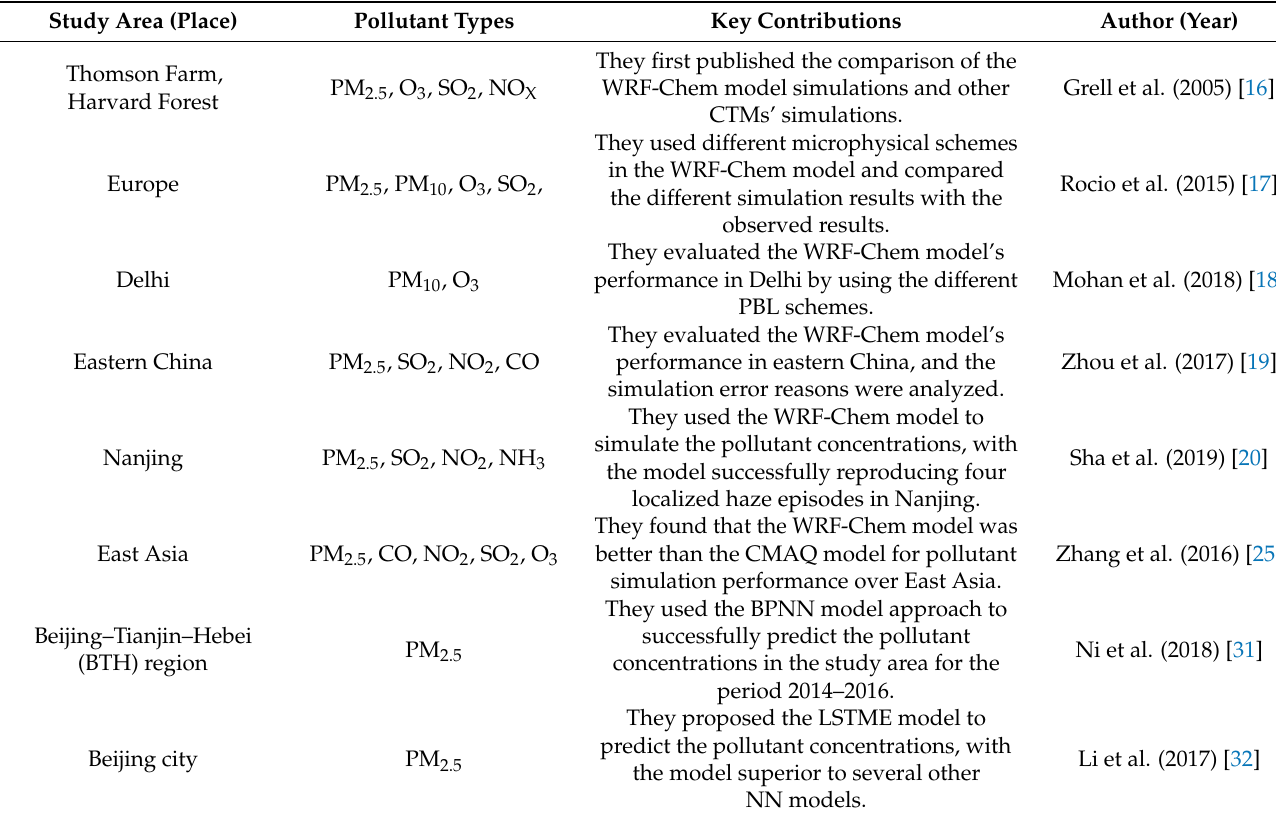
Table 1. Listed major air pollutant models in the